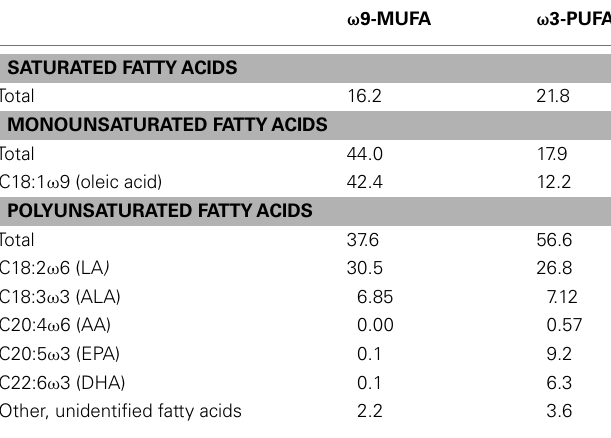
Table 1 | Fatty acid composition of ω 9-MUFA and ω 3-PUFA